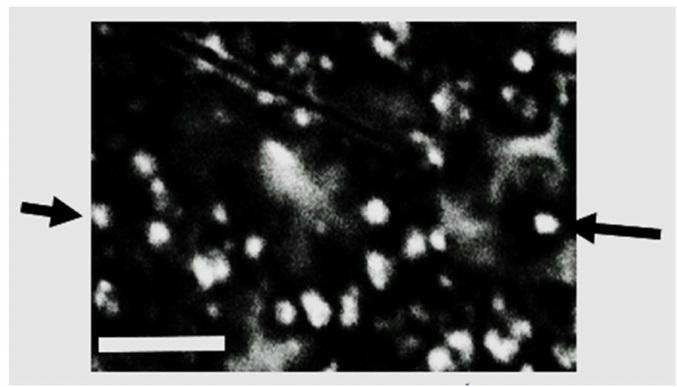
Figure 5. Scanning electromicrograph showing the spherical shape of biogenic nanogold particles (denoted by black arrows) (scale bar 100 nm).